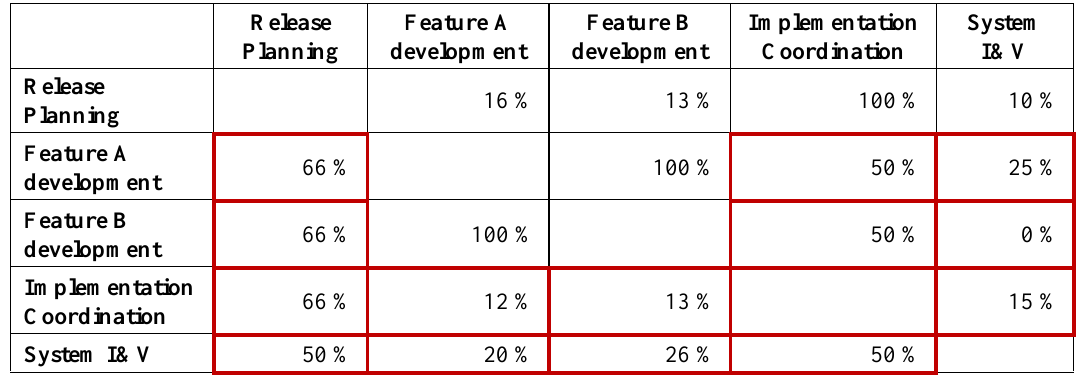
Table 6. A relative inter-professional